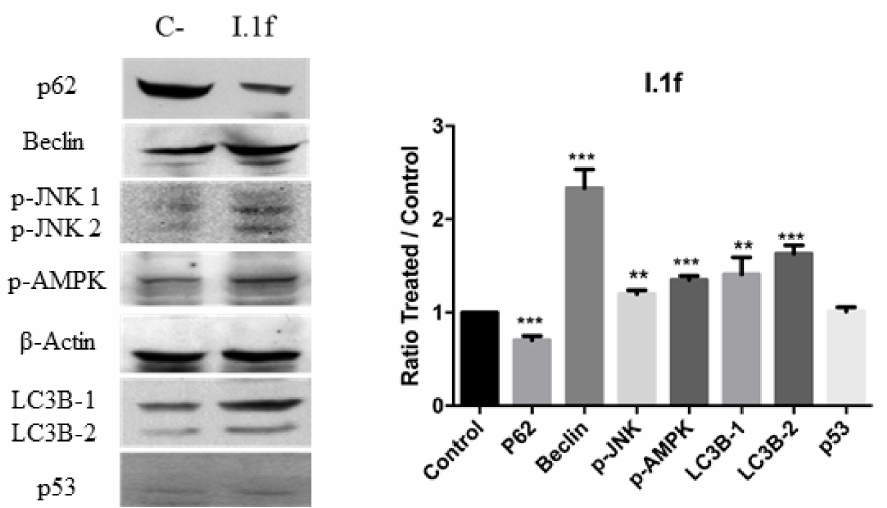
Figure 10. Western blot analysis of autophagy markers SQSTM1/p62, Beclin-1, p-JNKm p-AMPK, LC3B and p53 of MCF-7 cell culture treated with I.1f. ** statistical significance with values of p < 0.01; *** statistical significance with values of p <